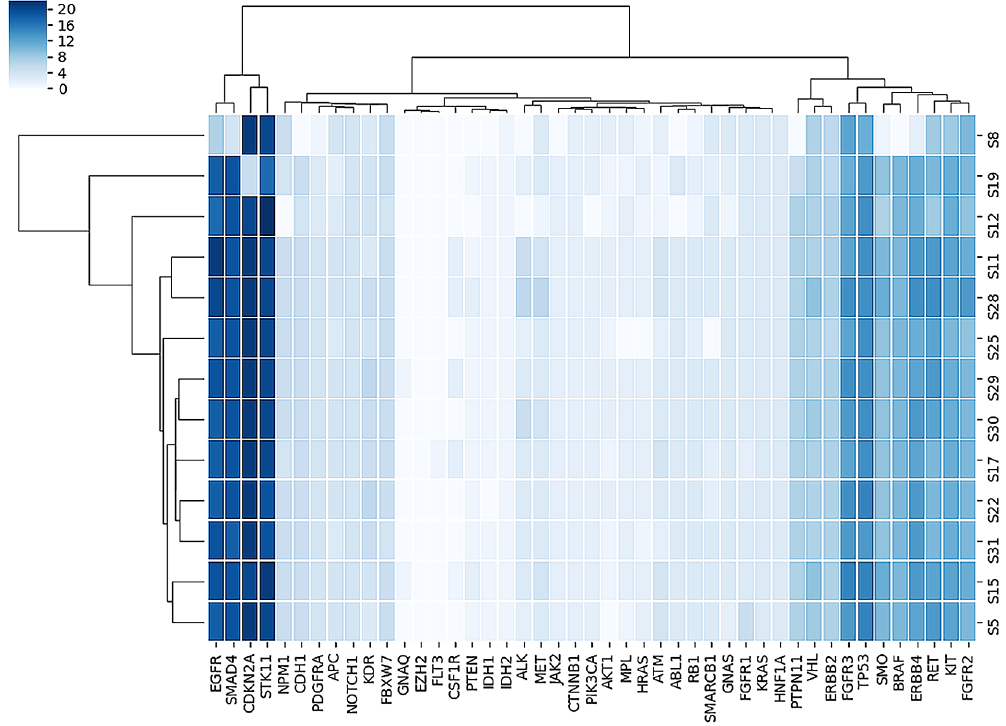
Figure 2. Plot of heatmap of number of non-synonymous variants observed in each gene for each